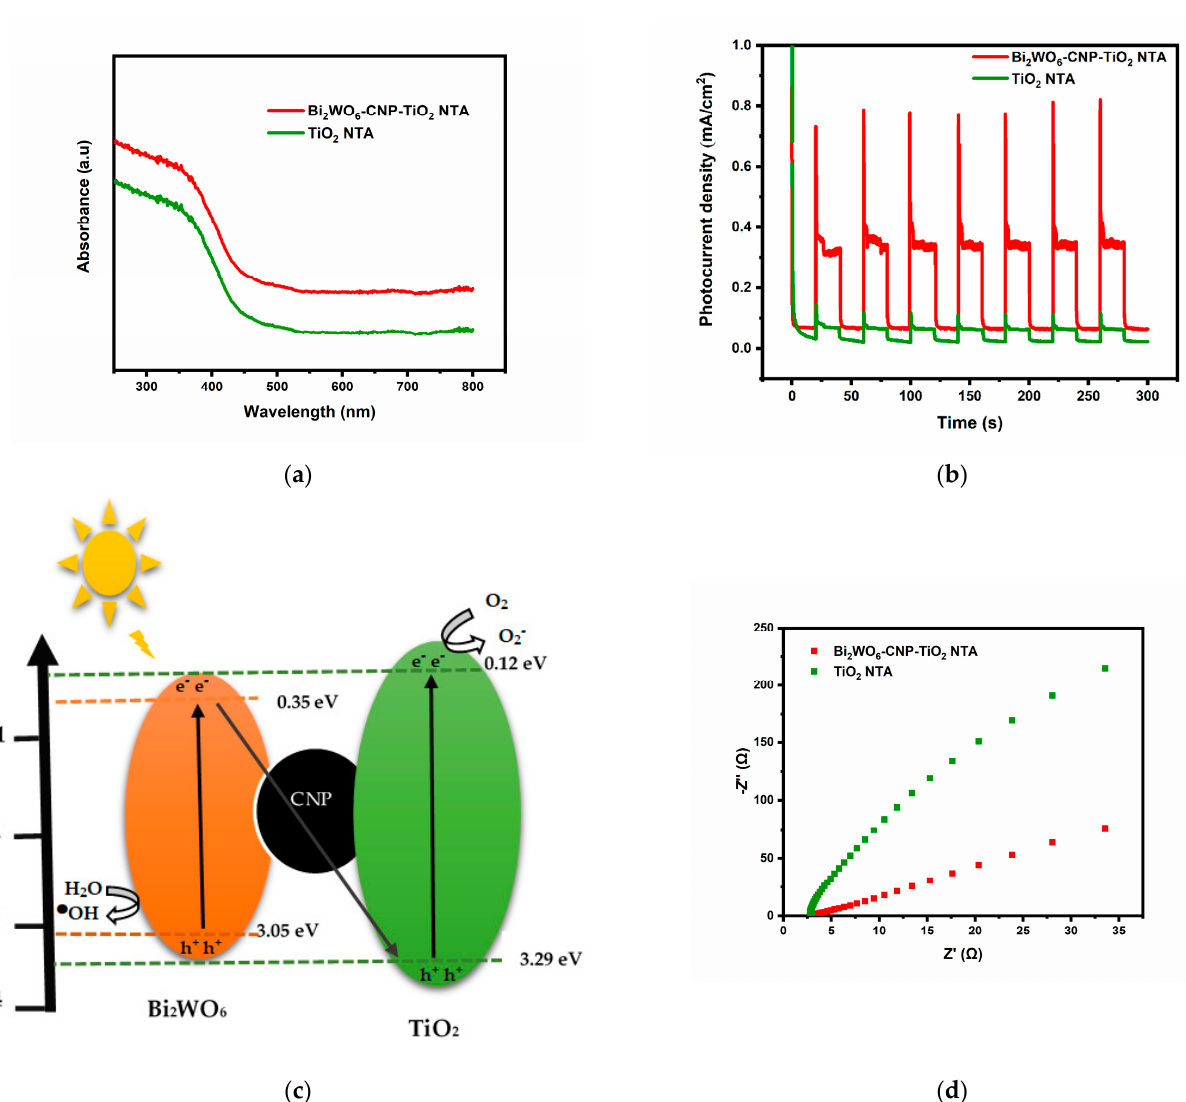
Figure 3. ( a ) UV-Visible diffuse reflectance spectra TiO 2 NTA Bi 2 WO 6 -CNP- TiO 2 NTA ( b ) photo- current responses of TiO 2 NTA and Bi 2 WO 6 -CNP- TiO 2 NTA in 0.1 M Na 2 SO 4 ( c ) schematic diagram of Z-scheme mechanism of Bi 2 WO 6 -CNP-TiO 2 NTA electrode ( d ) Nyquist plot TiO 2 NTA and Bi 2 WO 6 -CNP- TiO 2 NTA photoanodes in 5 mM [Fe(CN) 6 ] 3 − /4 − in 0.1 M KCl (pH 7).